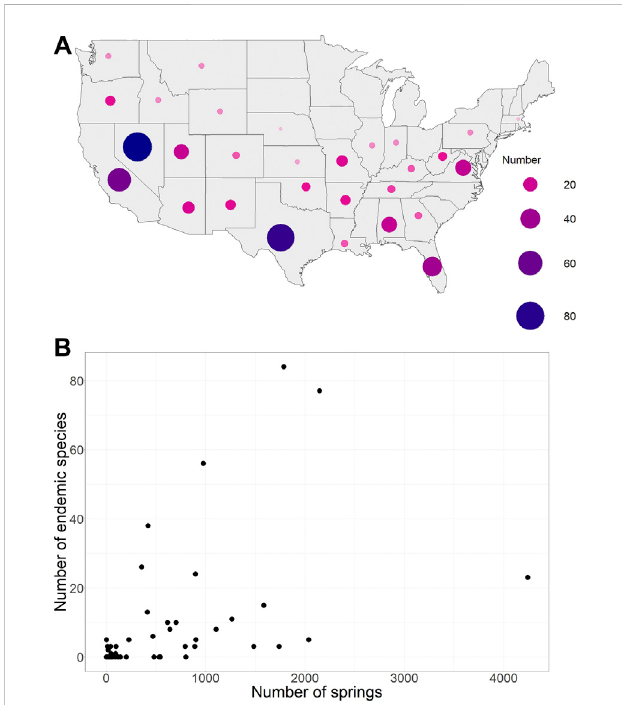
FIGURE 5 The distribution of species endemic to springs in the US (A) , as represented in the literature, and the relationship between the number of endemic species and the average spring size for a state (B) . The numbers range from 0 species to over 80endemicspecies within a